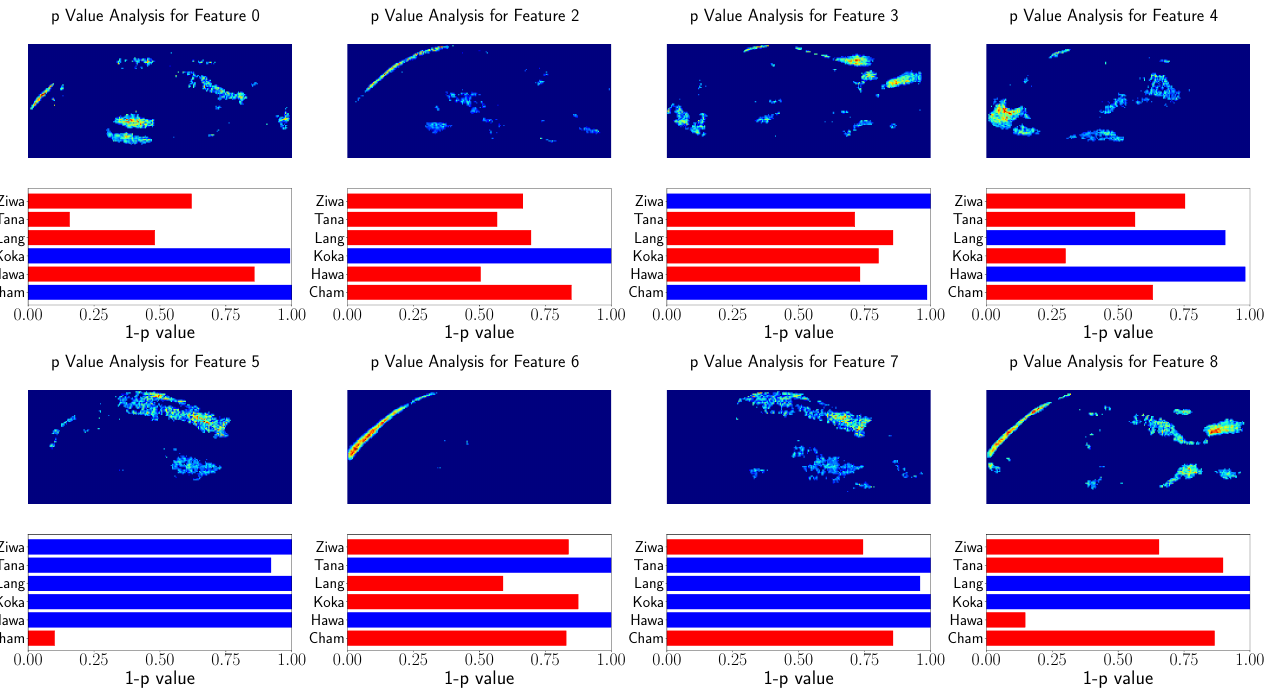
Figure 10. Result of Spearman’s rank correlation test for the relation between the manually selected cAE features and population locations in Ethiopia. Randomly selected features are visualized. Features with a p -value above α = 0.1 are shown as red